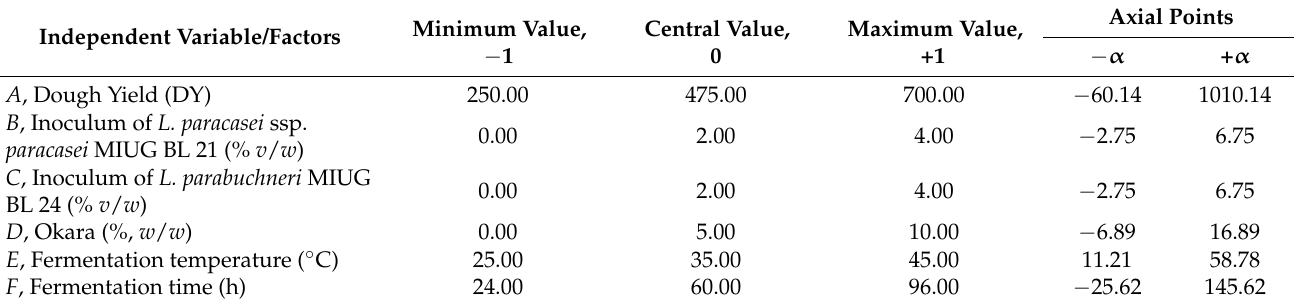
Table 2. Response Surface Methodology (RSM)